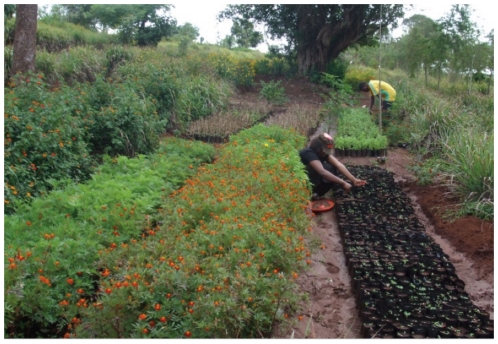
Concern Plant Nursery in Ngara.